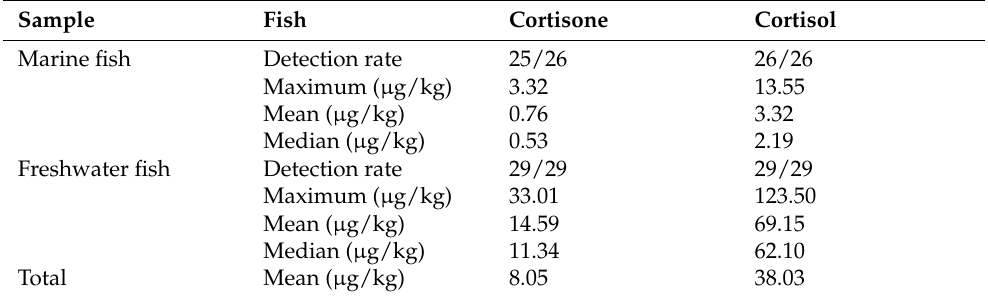
Table 1. The concentrations of cortisone and cortisol in marine fish and freshwater